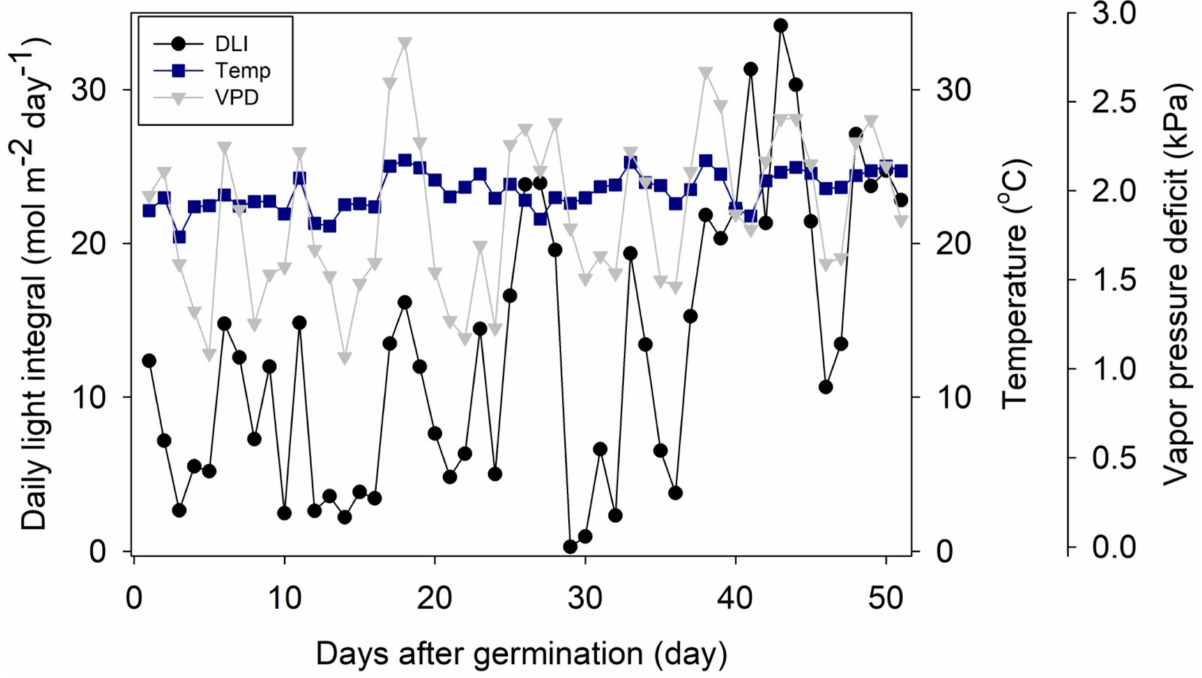
Figure 1. Daily light integral, temperature, and vapor pressure deficit of the greenhouse throughout the experimental